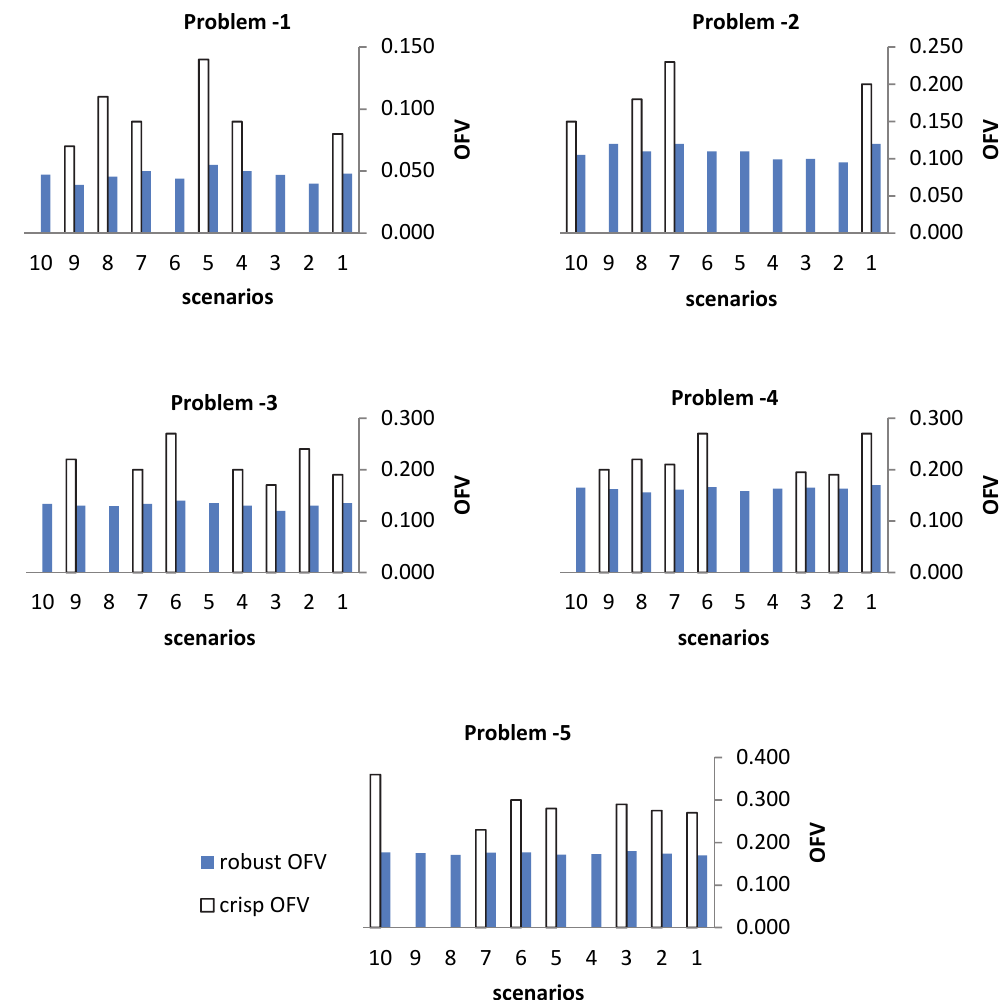
Fig. 1. Evaluation of the LP-metric objective-function values for both deterministic and robust models in five test